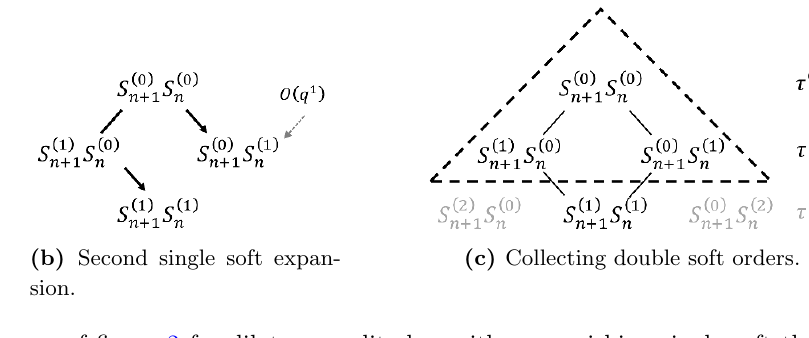
Figure 3. A special case of (cid:12)gure 2 for dilaton amplitudes, with nonvanishing single soft theo- rem and (cid:21) = 1. For double soft order (cid:21) + 1 = 2, there are terms unattainable from single soft expansion. Therefore, double soft theorem only exists up to order (cid:21) = 1, and the information of (cid:16) (cid:17) (cid:16) (cid:17) p (cid:1) S (1) q (cid:1) S (1) n is n +1